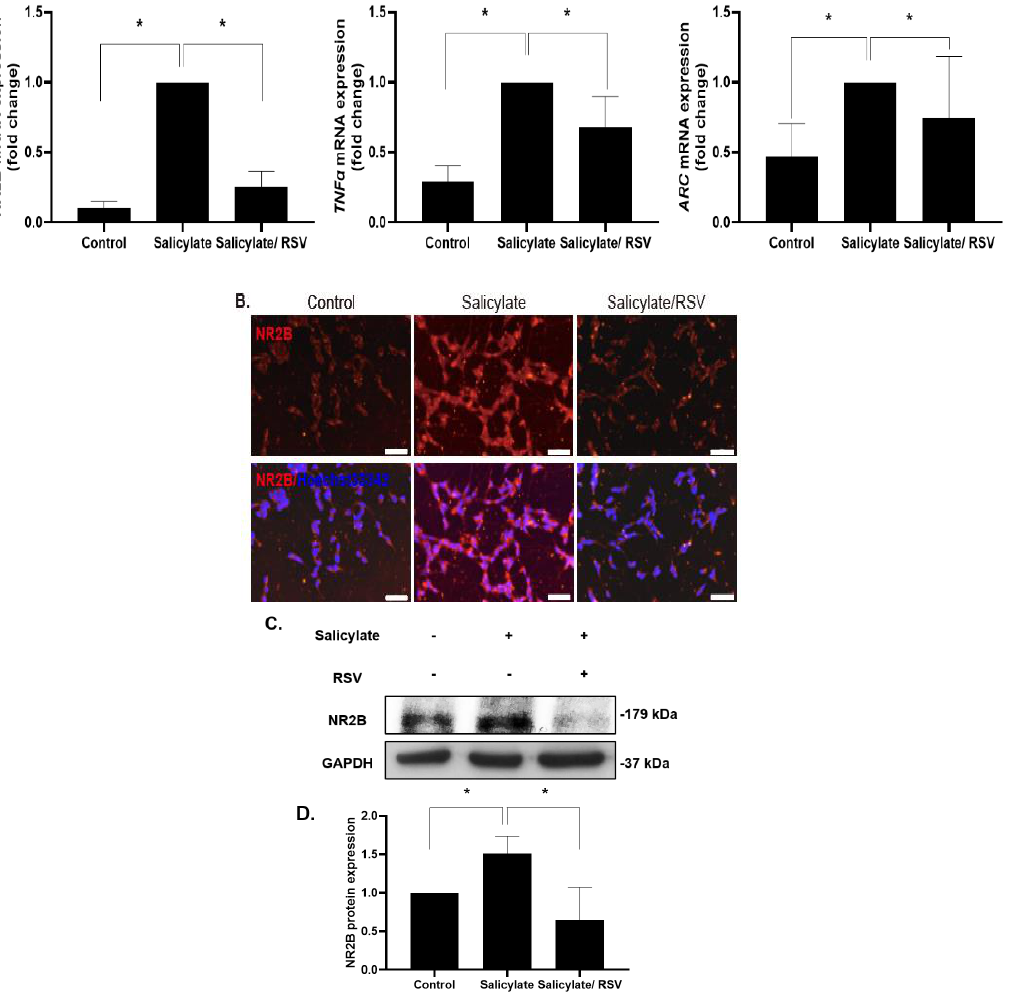
Figure 1. Expression of NR2B, TNFα , and the immediate early gene ARC in RSV-treated neuronal cells. Salicylate significantly increased the expression of NR2B , TNFα , and the immediate early gene ARC, whose expression was decreased in resveratrol (RSV) pretreated SH-SY5Y cells, as measured by quantitative polymerase chain reaction ( A ); * p < 0.05, mean ± SD. NR2B expression in SH-SY5Y cells increased with salicylate treatment and decreased with RSV pretreatment, as demonstrated by immunocytochemical staining ( B ) and immunoblot analysis ( C ). Western blot experiments were re- peated and the bands were quantified using ImageJ software ( D ); * p < 0.05, mean ± SD. ARC: activ- ity-regulated cytoskeleton- associated protein; TNFα : tumor necrosis factor-alpha; NR2B: NMDA receptor subunit 2B. Scale bar = 50 um. 2.2. RSV Pretreatment Decreases Phosphorylated CREB in Salicylate-Treated Neuronal Cells Immunocytochemical staining and an immunoblotting analysis demonstrated that the p-CREB content increased in the salicylate-treated cells. There was no decrease with the RSV pretreatment (Figure 2A,B). Immunoblot assays were repeated three times and the p-CREB expression was quantified (Figure 2C). Figure 2. Phosphorylation of cAMP response element-binding protein (CREB) was reduced in resveratrol (RSV)-pretreated neuronal cells. Salicylate treatment induced CREB phosphorylation, which was reduced in RSV-pretreated SH-SY5Y cells as shown by immunocytochemistry staining ( A ) (scale bar = 100 µm) and immunoblot analysis ( B ). Western blot data were quantified and pre- sented as a graph ( C ); * p < 0.05, mean ± SD. GAPDH was used as the internal standard. Scale bar = 100 um.